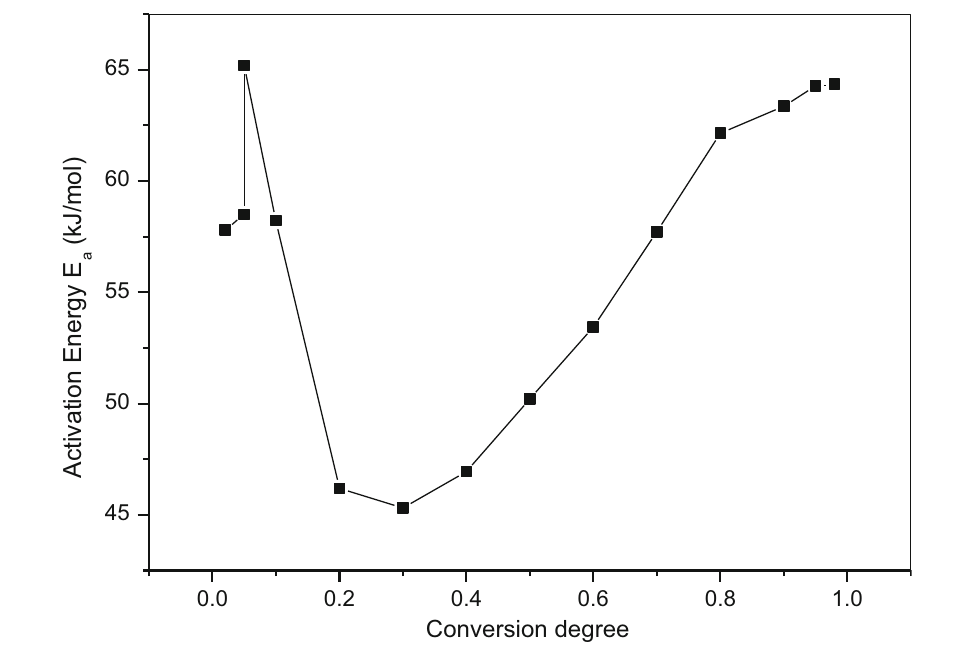
Fig. 11 Activation energy with function of conversion using the Friedman analysis Table 7 Activation energy for Indian low rank coal compared with other low rank coal samples Different low rank coal